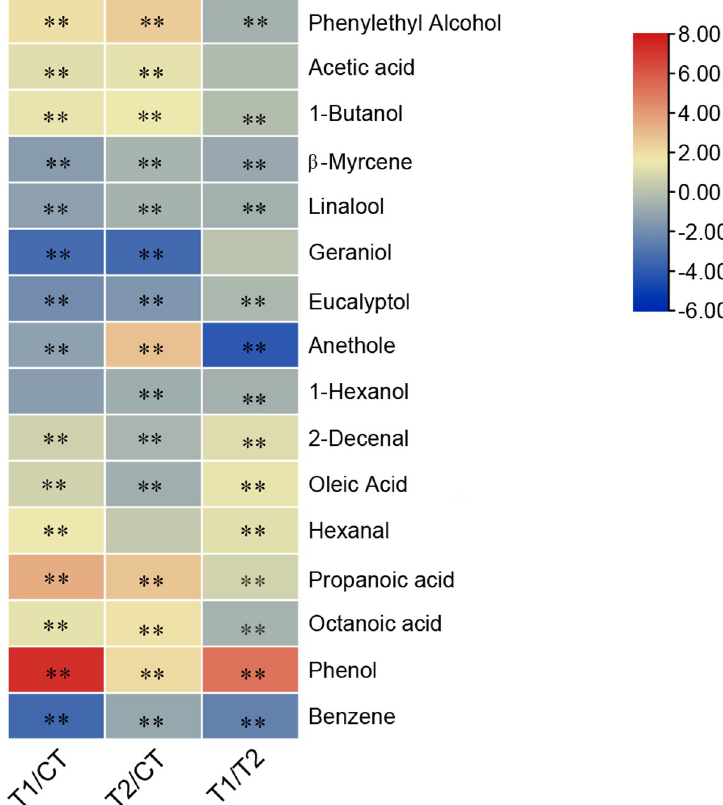
Fig 6. Identification of significant key metabolites by GC-MS in fermented food waste sample. The major metabolites were selected based on fold-change [log 2 (T1/CT), log 2 (T2/CT), log 2 (T1/T2)], in addition to exhibiting a statistically significant difference. � 0.001 < P < 0.05; �� P <